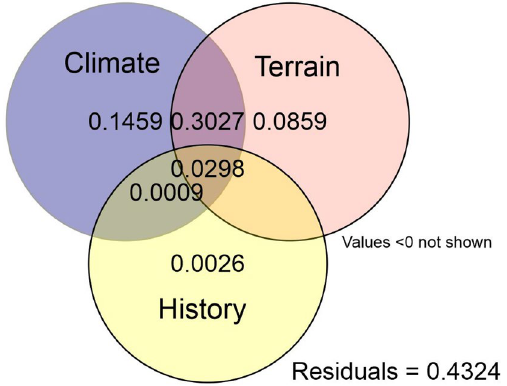
Figure 7. Venn diagram of variance partioning of data grouped into three subsets: Climate, Terrain, and History (see Table 1). Credit: R Core Team 43